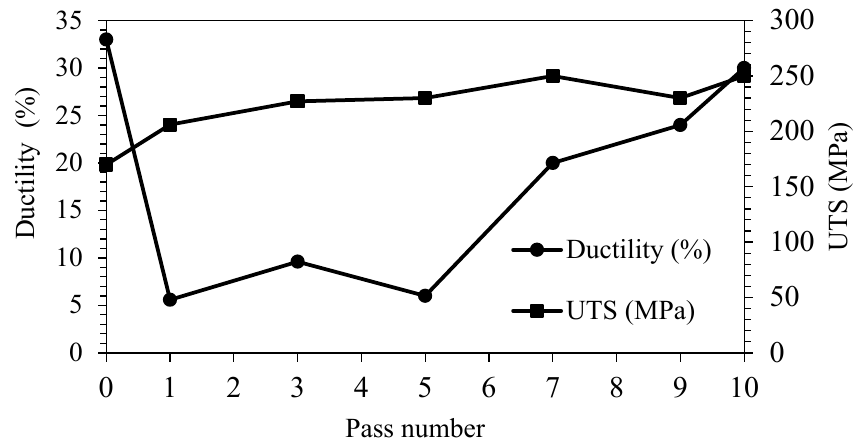
Figure 8. Comparison of the ductility and UTS values vs. the modified ‐ CSP passes.